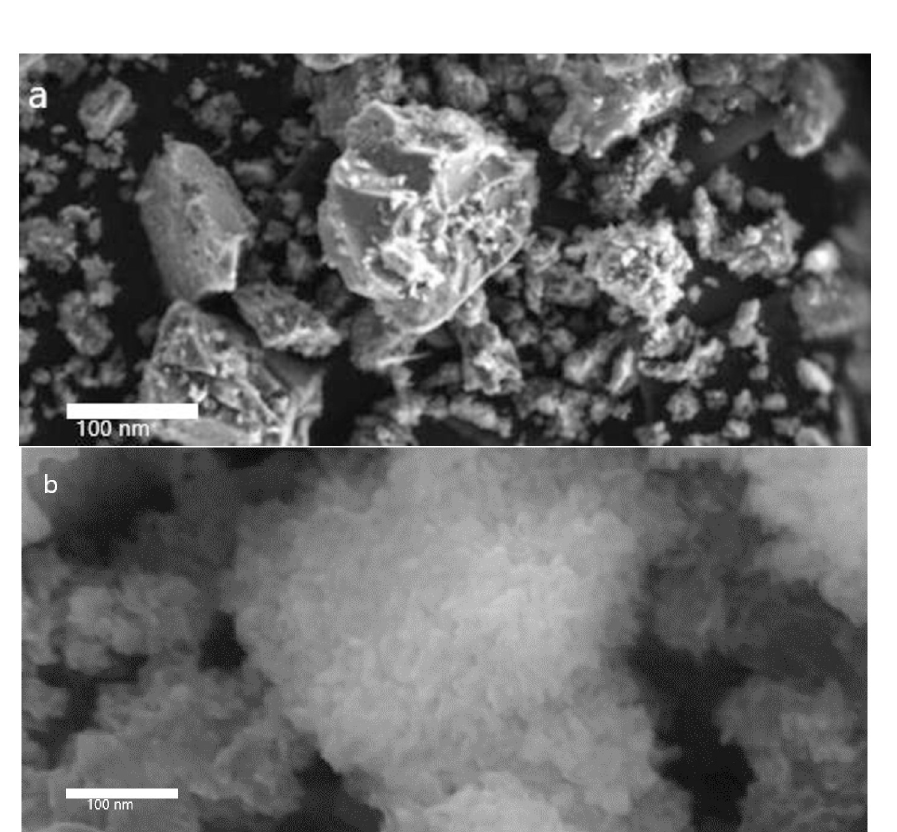
Fig 5. S.E.M. microstructure of Al 2 O 3 (a) and SnCaAl 2 O 3 nanoparticles (b).